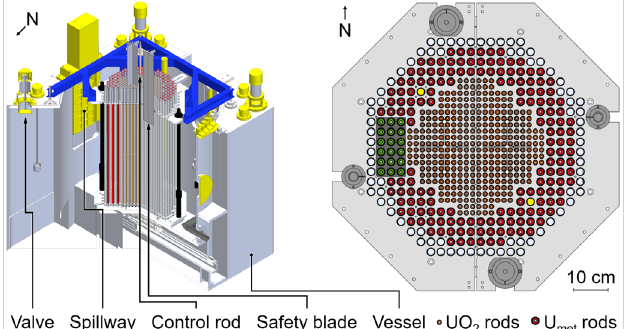
Fig. 1. View of the CROCUS reactor (left), and the core superior grid and configuration with the oscillation location (highlighted with green U met